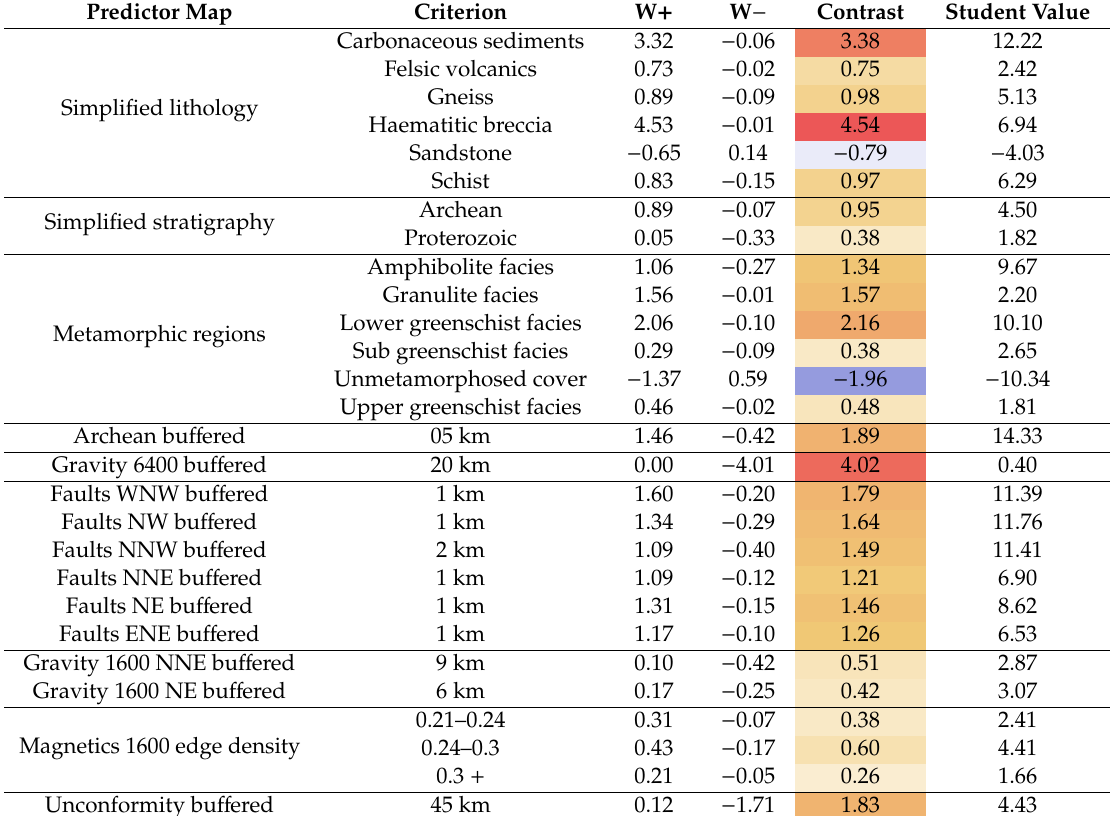
Table 4. Calculated weights of evidence for the NW McArthur Basin study. Uranium occurrences as the training set. For multi-class predictors, only features that returned significant contrasts are shown. Where multi-ring bu ff ers have been used around features, the bu ff er with the highest contrast is shown. W + = positive weight of evidence, W − = negative weight of evidence. The contrast is the di ff erence between the positive and negative weights. A positive or negative contrast signifies a net positive or net negative spatial association respectively. Higher contrast values are highlighted by warmer coloured (orange to red) shading and negative contrast values are highlighted by cooler colours (blues). The student value is an approximate ‘Student t test’, and provides a measure of the statistical validity of the contrast. A student value of ‘2’ equates to a 98% confidence level in the calculated contrast; a student value of ‘1’ equates to an 85% confidence